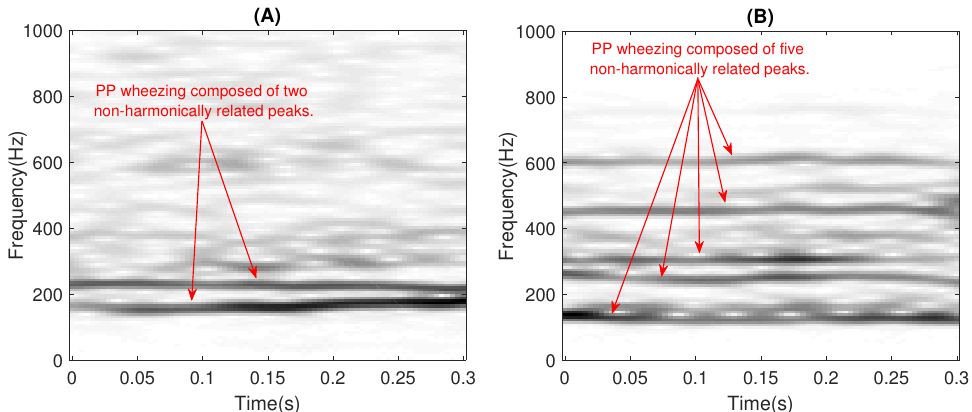
Figure 2. Time-frequency representation of two examples of Polyphonic (PP) wheezing: ( A ) with two non-harmonically related peaks; ( B ) with five non-harmonically related peaks. Note that the frequency components are not harmonically related in the case of PP